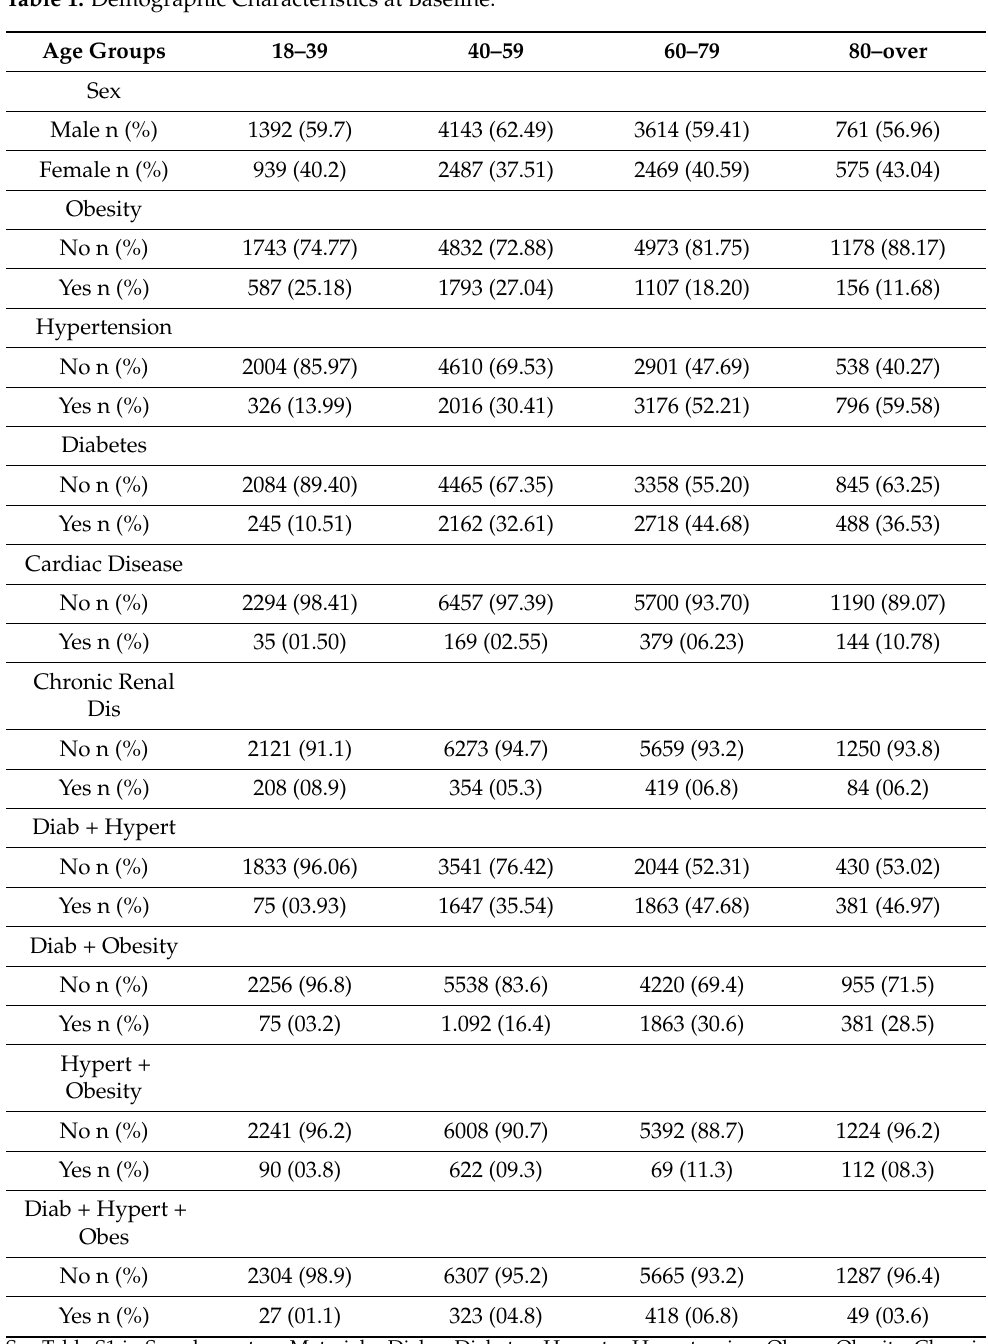
Table 1. Demographic Characteristics at